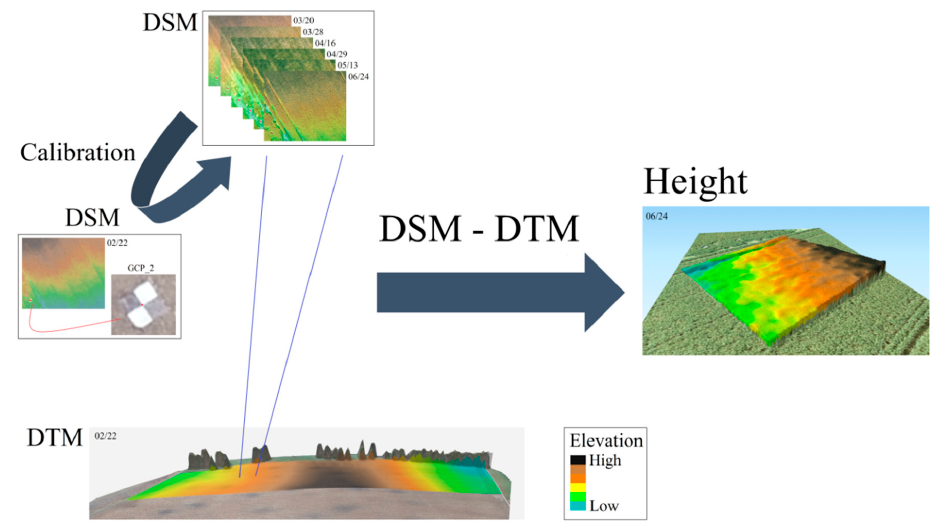
Figure 3. Methodological workflow to derive plants height from RGB images collected by the unmanned aerial vehicle. DTM is the digital terrain model acquired on 22 February when the field was completely bare soil. DSM represents the digital surface model at each acquisition date. Ground control point 2 was used as a reference levelling point to calibrate the DSM images.